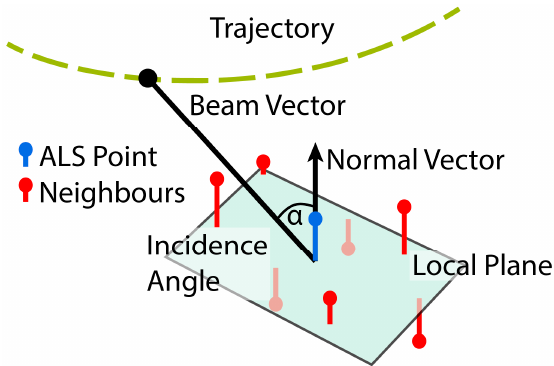
Figure 3. Illustration of the beam vector and normal vector of a laser pulse. The beam vector is calculated using absolute position and orientation information about the laser beam origin.